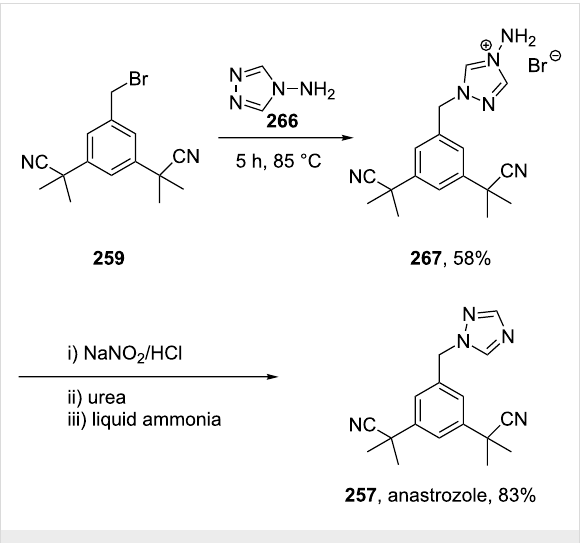
Scheme 52: Regioselective synthesis of